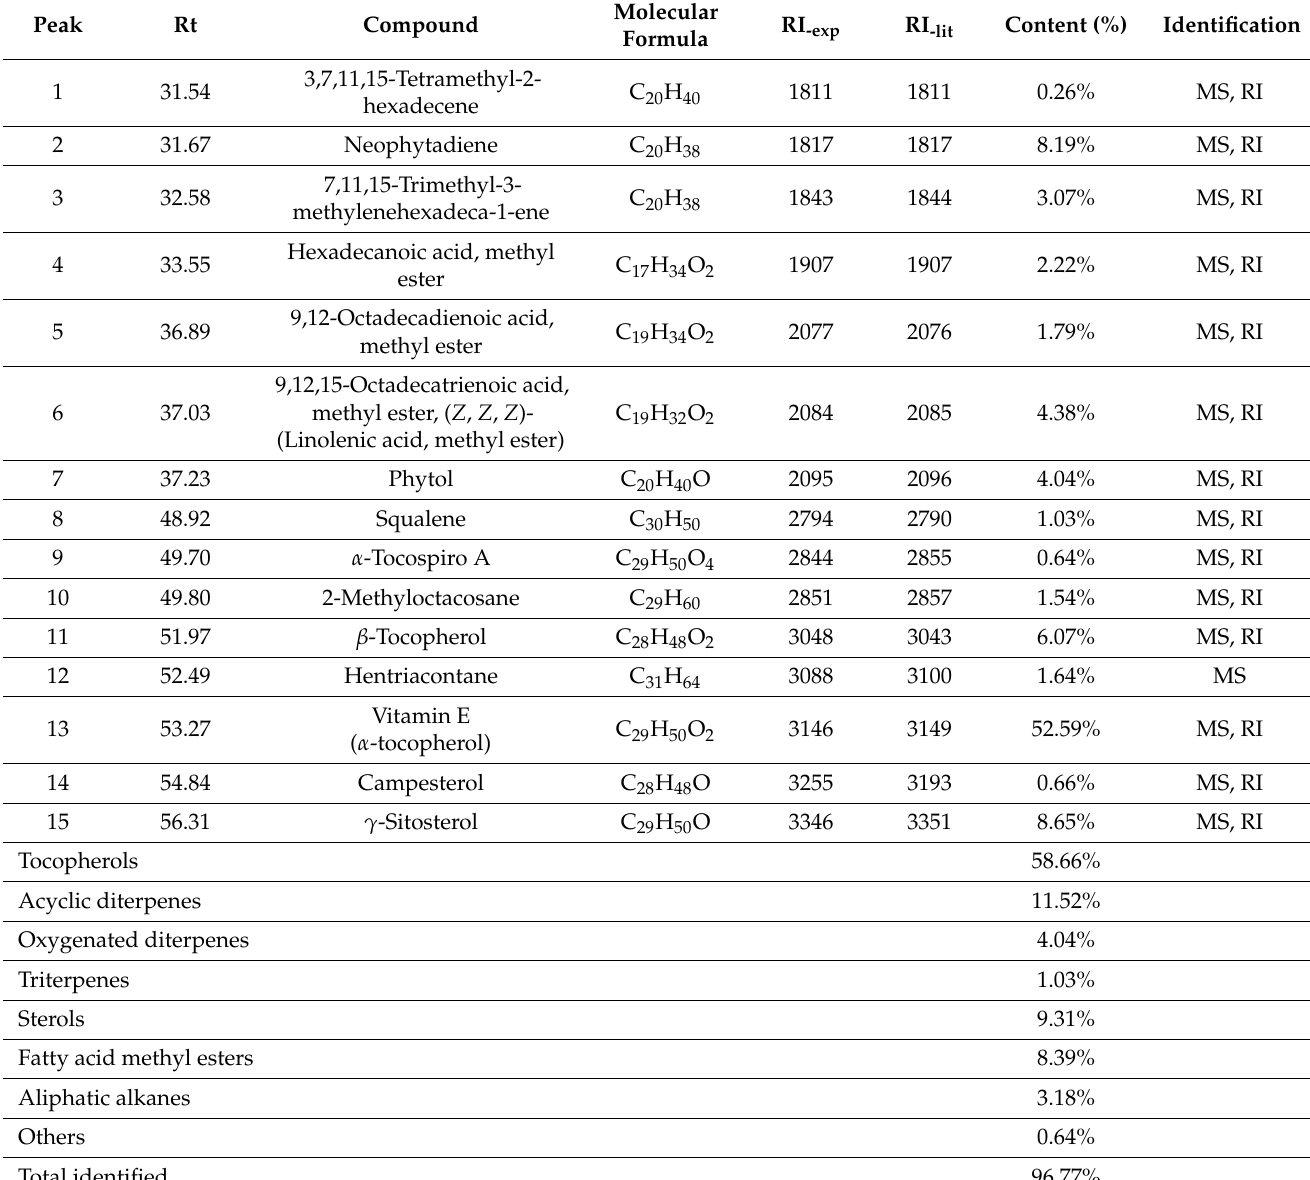
Table 1. Chemical profile of the prepared lipophilic extract from the leaves of Stenocarpus sinuatus